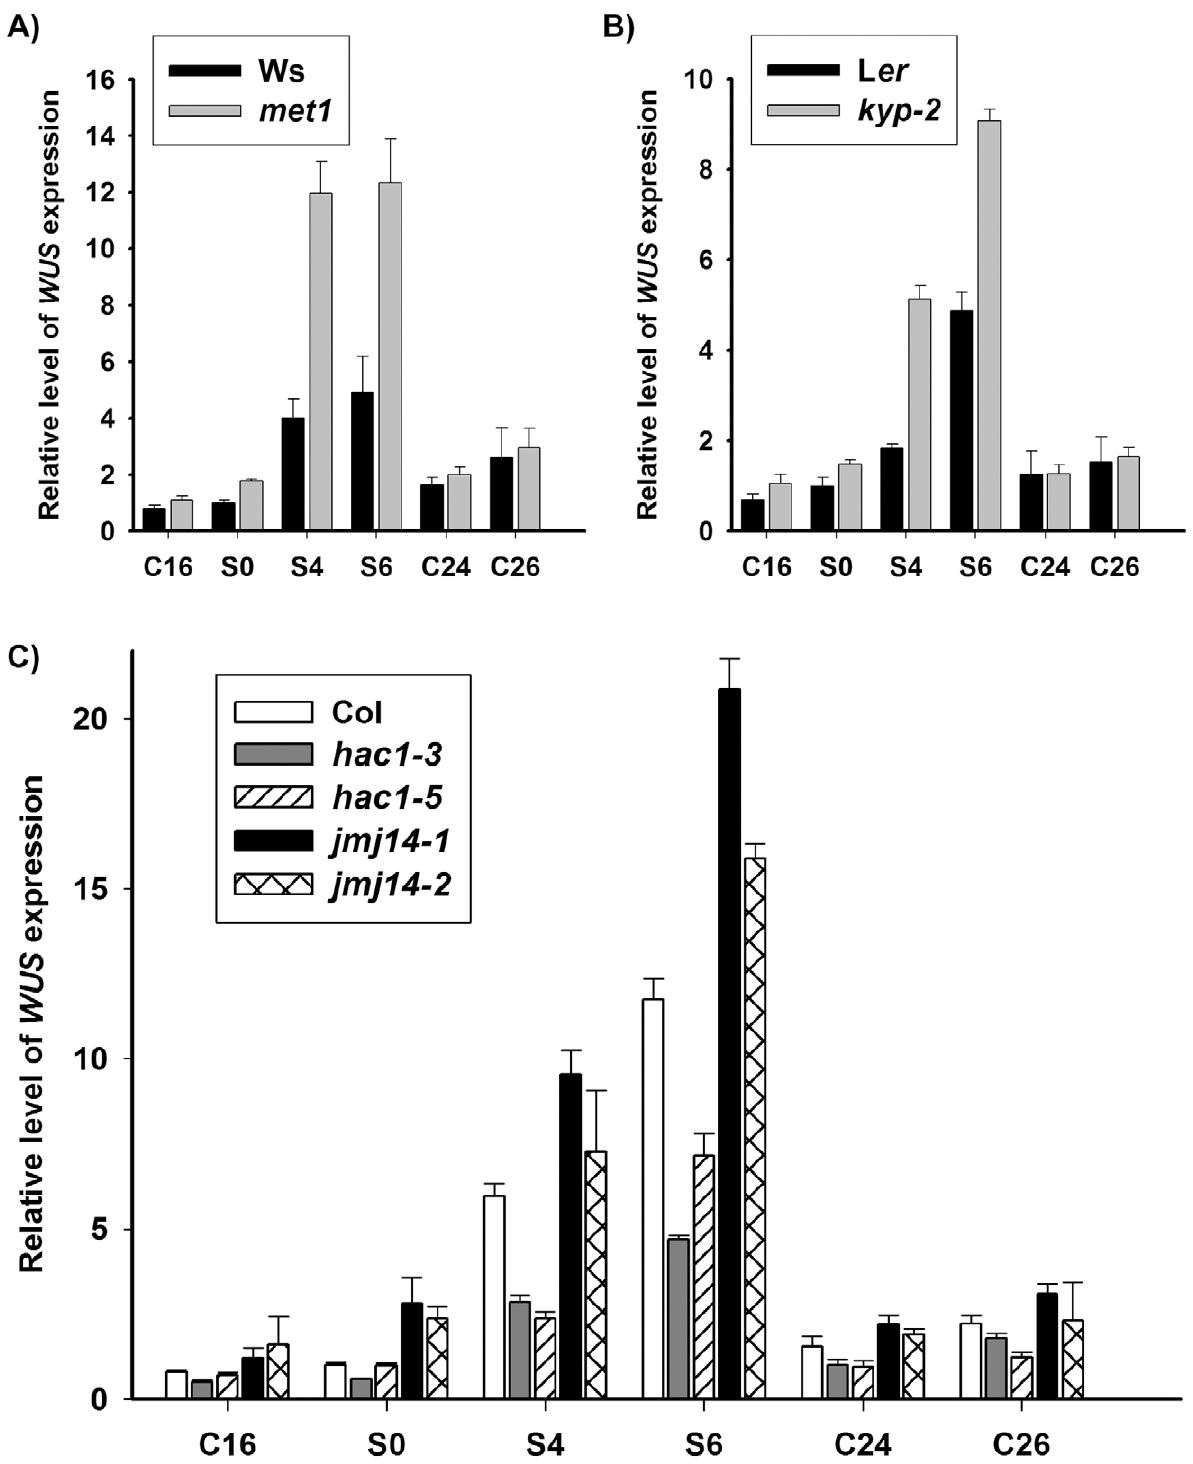
Figure 2. DNA methylation and histone modifications regulate WUS transcript levels. A) Transcript levels of WUS in calli of the wild type (Ws) and the mutant met1 . B) Transcript levels of WUS in calli of the wild type (L er ) and the mutant kyp-2 . C) Transcript levels of WUS in calli of the wild type (Col) and the mutants, hac1-3 , hac1- 5, jmj14-1 and jmj14-2 . Total RNAs were isolated from calli of wild type (Ws, L er and Col) and various mutants ( met1 , kyp-2 , jmj14-1 , jmj14-2 , hac1-3 and hac1-5 ) cultured on SIM at the indicated time points, respectively. WUS transcript levels were quantified by qRT-PCR. The results are shown as mean values of three biological replicates with standard errors. The relative expression level of WUS gene, corresponding to the expression level of TUBULIN2 , was calculated using the comparative C(T) method. After incubating on CIM for 20 days (S0), some of the calli were transferred onto SIM for further induction for 4 days (S4) and 6 days (S6), other calli were still cultured on CIM as controls (C24, C26). C16, C24, C26 indicated that pistils as explants were cultured on CIM for 16 days, 24 days and 26 days, respectively.